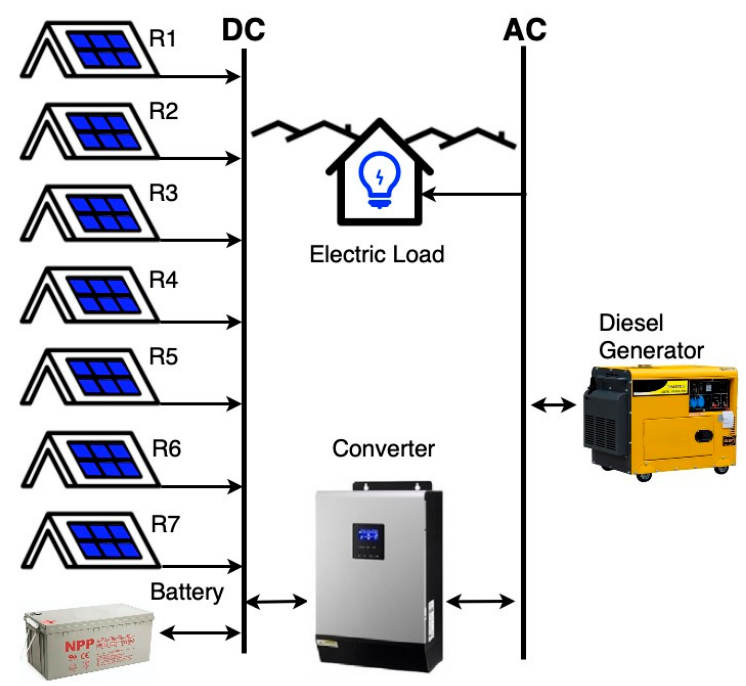
Figure 8. Components of the HES microgrid.